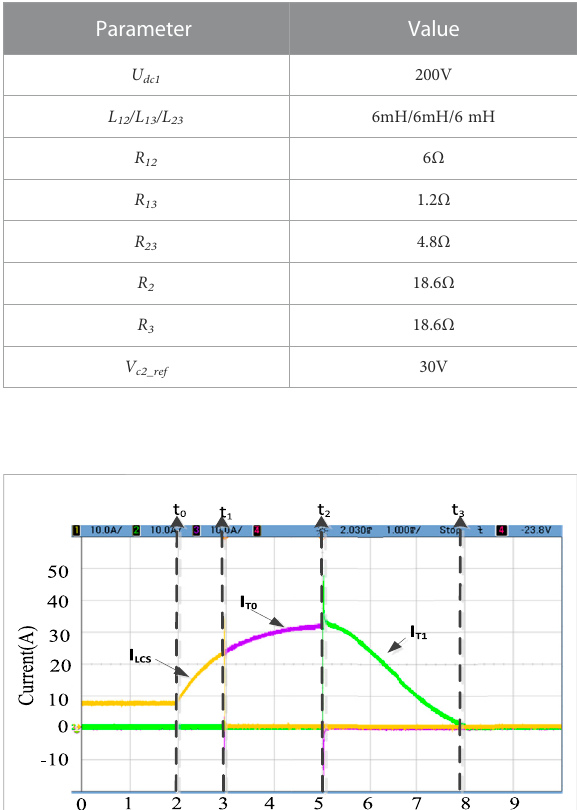
TABLE 3 Parameters of the experimental system.